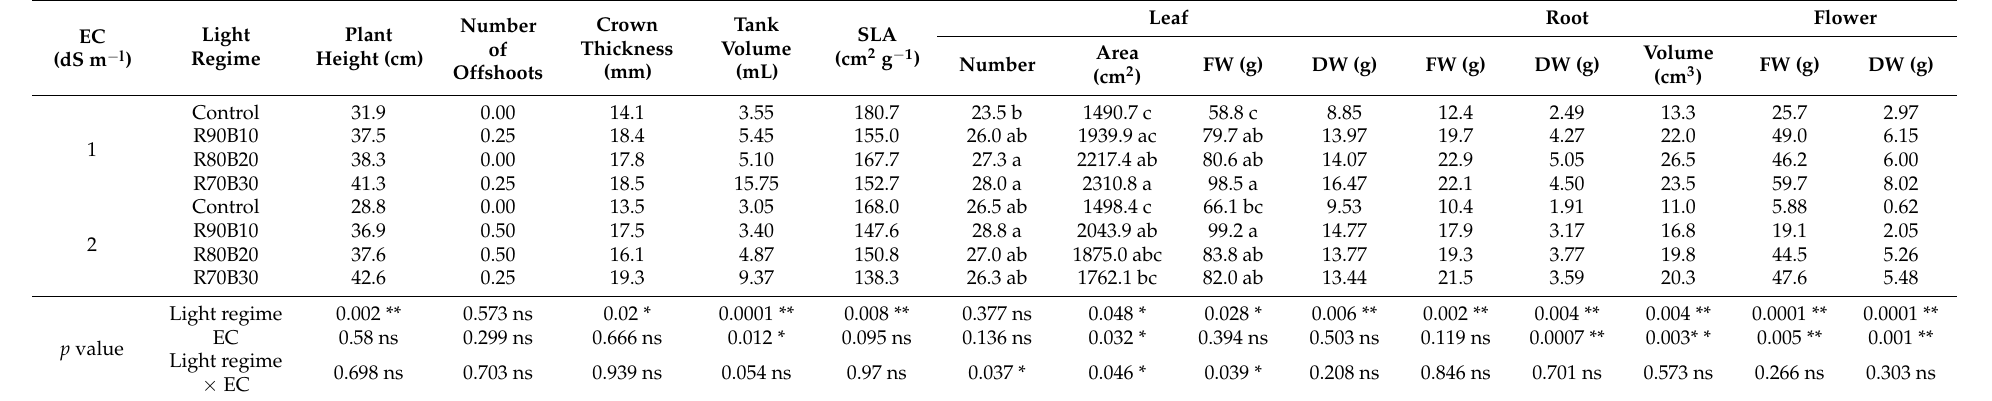
Table 3. Effect of supplementary light and nutrient solution electrical conductivity (EC) on growth and morphology of Guzmania ‘Rostara’ plants. The light treatment included control (no supplementary light), R90B10 [90% red (R) and 10% blue (B)], R80B20 (80% R and 20% B), and R70B30 (70% R and 30% B), while the EC values employed were 1 and 2 dS m − l . Four replicate plants were assessed per treatment. In traits, where the interaction of the two factors (light regime, EC) was significant, different letters indicate significant differences. FW, fresh weight; DW, dry